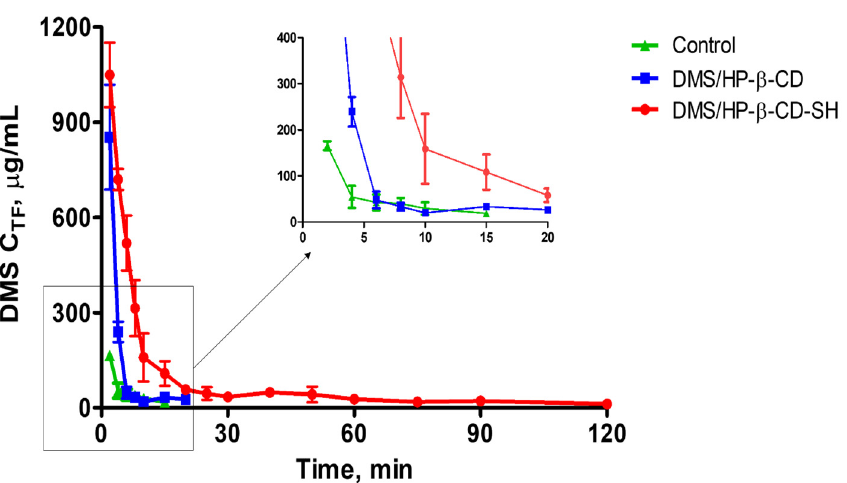
Figure 7. Profiles of DMS elimination from tear fluid of rabbits following instillation of one eye drop (50 µ L) containing 0.3% w/v DMS alone or DMS and 12.5% w/v of different CDs. Each point is the mean ± SD of at least 6 values.